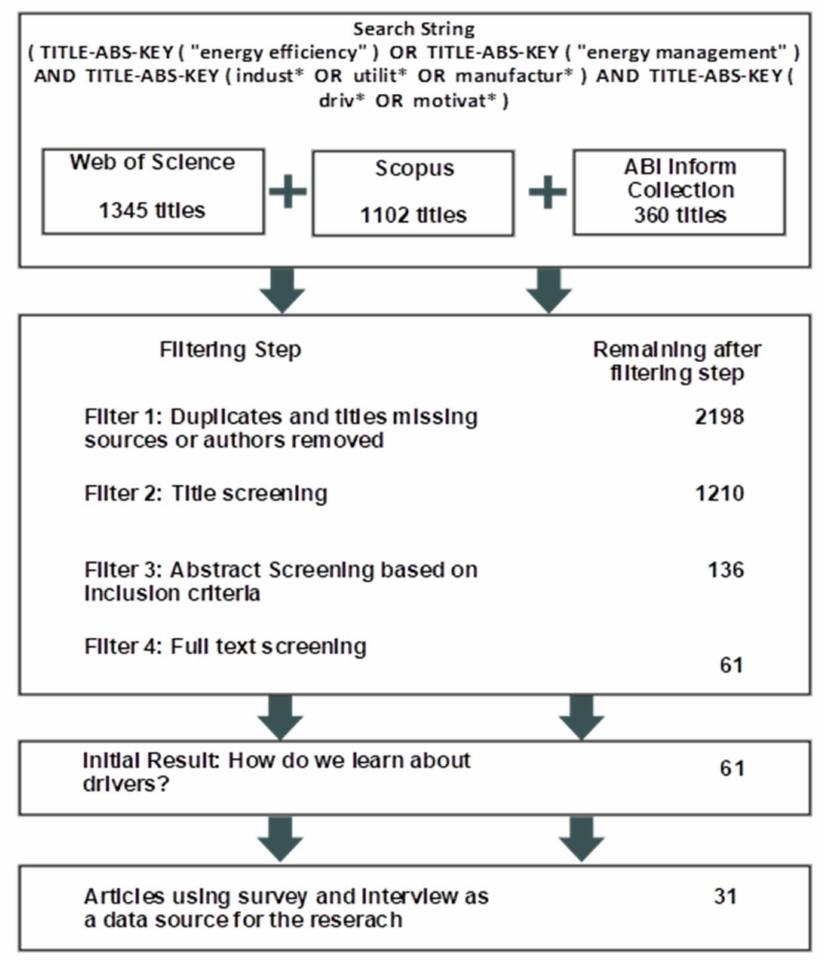
Figure 1. Systematic literature review flow chart. The * represents a wildcard in the search